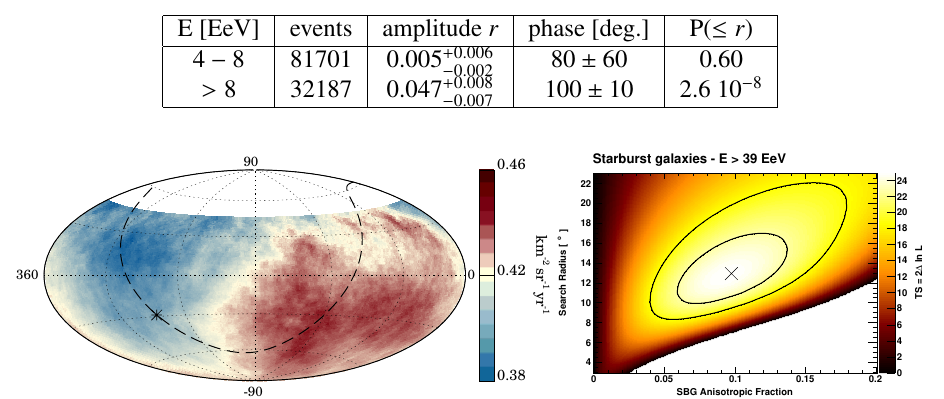
Table 1. Data from the Rayleigh analysis of the first harmonic in right ascension for the two energy bins [9].